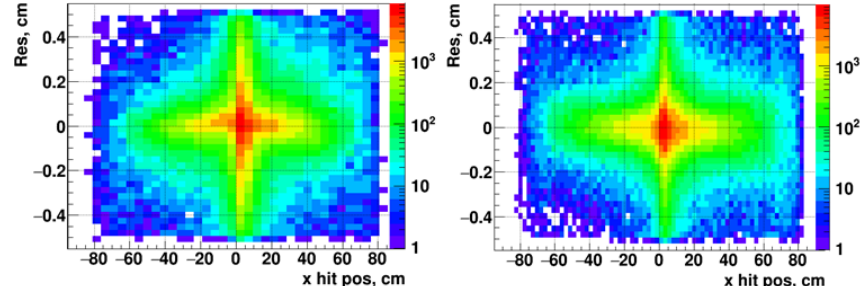
Figure 6. The x-coordinate residuals of hits with respect to tracks as a function of hit x-positions in the GEM detector: left) for carbon data, right) for simulated tracks